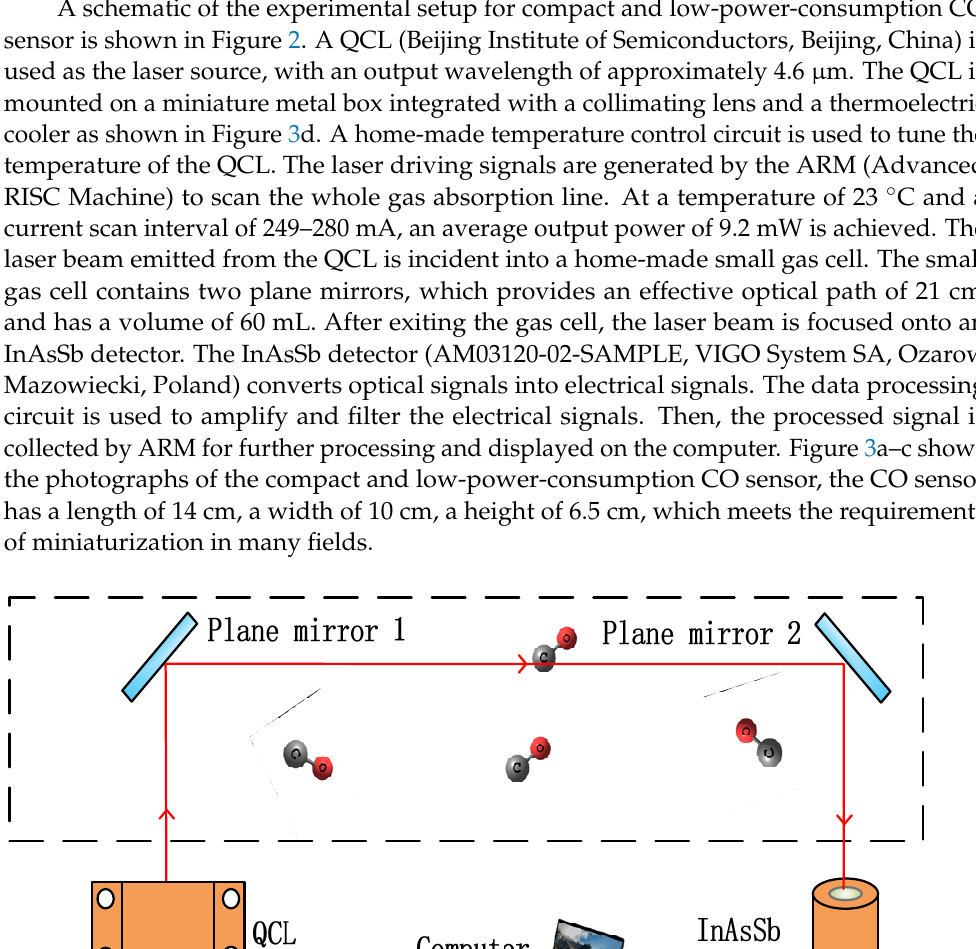
Figure 2. Schematic drawings of the compact and low-power-consumption CO sensor.